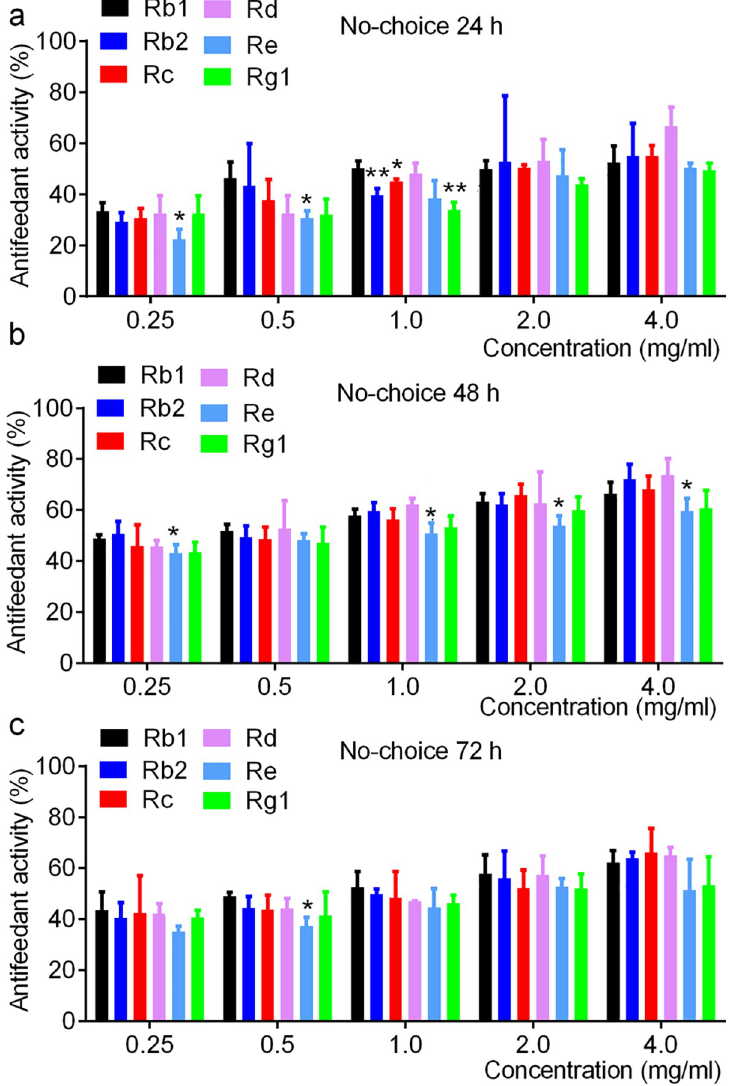
72 h, respectively. � and �� notes p < 0.05 and 0.01 vs. Rb1 in each concentration, respectively. Original data are available from S4